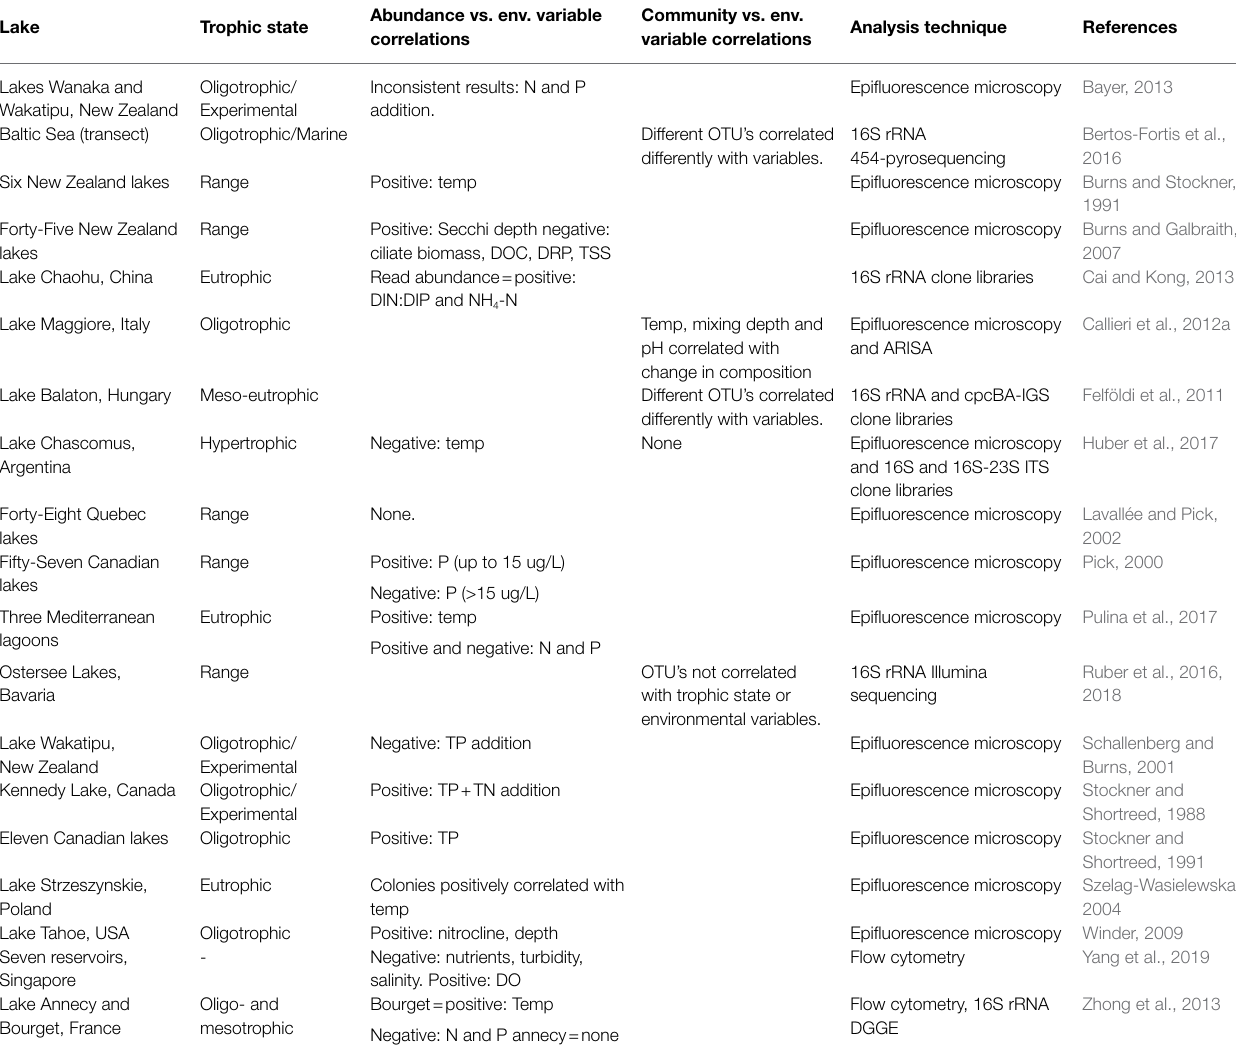
TABLE 1 | Studies correlating picocyanobacterial abundances or communities with environmental drivers and the resulting significant correlations